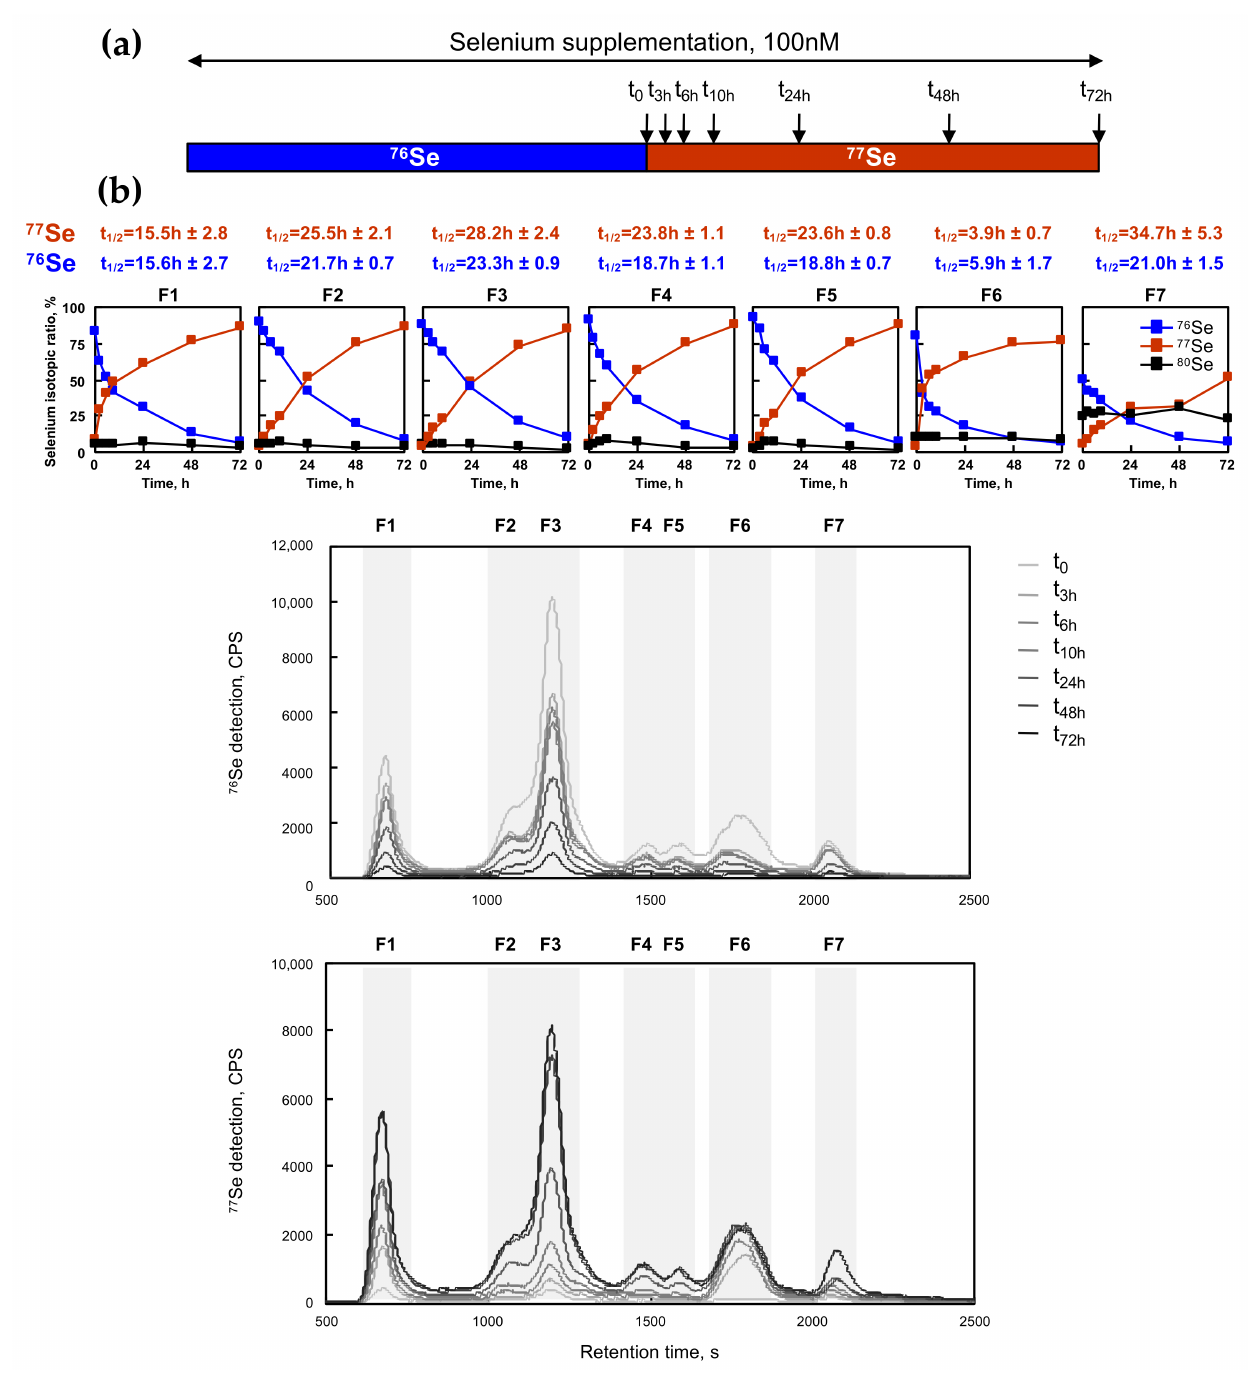
Figure 6. Time-course analysis of selenoprotein expression in medium containing 100 nM 77 Se. ( a ) Cells were grown for three days in a medium containing 76 Se (100 nM) prior to being plated in a fresh medium with 100 nM of 77 Se enriched selenium. Then, the cellular extracts were harvested at defined time post treatment (0, 3, 6, 10, 24, 48, and 72 h) and analyzed by SEC-ICP MS as described in Figure 4. ( b ) The chromatographic profiles for 76 Se and 77 Se are shown for the various cellular extracts in the bottom two panels. The isotopic pattern was analyzed in the seven identified fractions, as indicated by dashed boxes (F1 to F7). 76 Se, 77 Se and 80 Se are represented in blue, red and black squares, respectively. The kinetics for 76 Se and 77 Se abundance in each fraction as a function of time were fitted as described in experimental procedures. The results of t 1/2 for 76 Se and 77 Se for each fraction are indicated on top of the respective